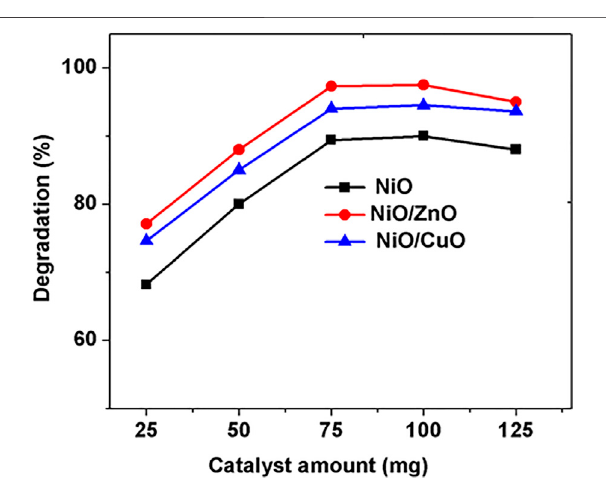
FIGURE 5 | Effect of pH on degradation of methylene blue dye.